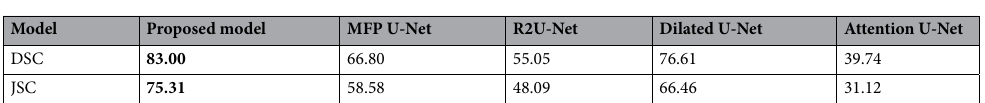
Table 3. Experiment results on CVC-Clinic public dataset for polyp segmentation using proposed and other U-Net based models. Significant values are given in